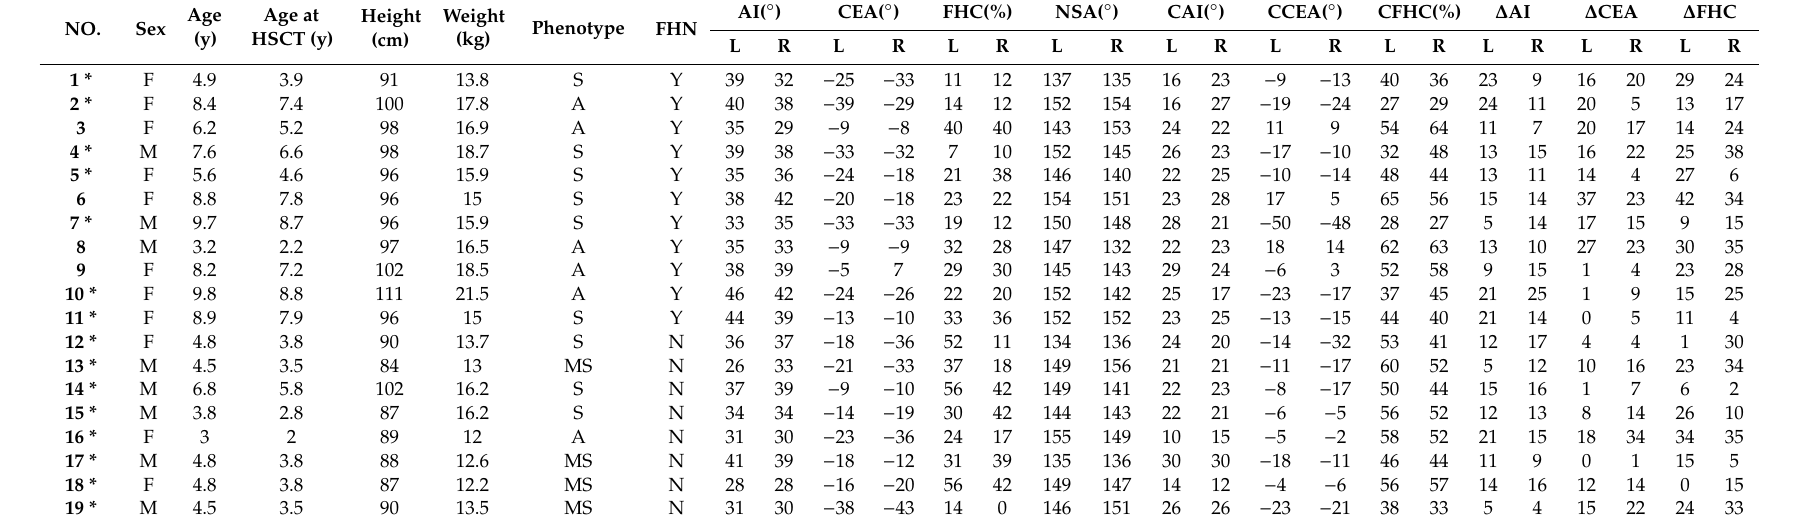
Table 1. Characteristics of patients with mucopolysaccharidosis IVA (MPS IVA).